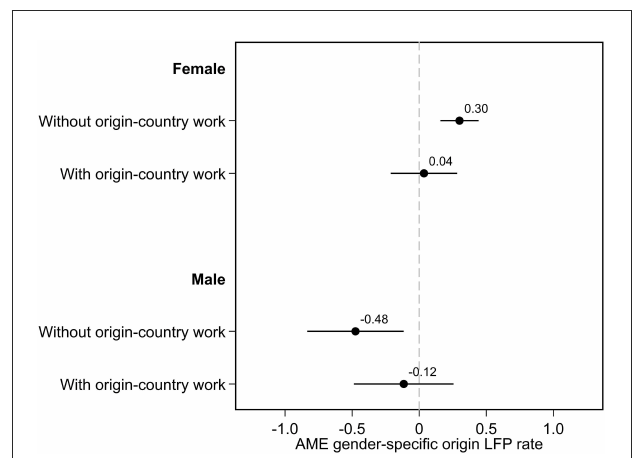
FIGURE2 Main results. AME (with 95% confidence intervals from robust standard errors) on employment for gender-specific origin-country LFP rate, separated by gender and origin-country work experience. Full results from logistic model in Supplementary Table 1.